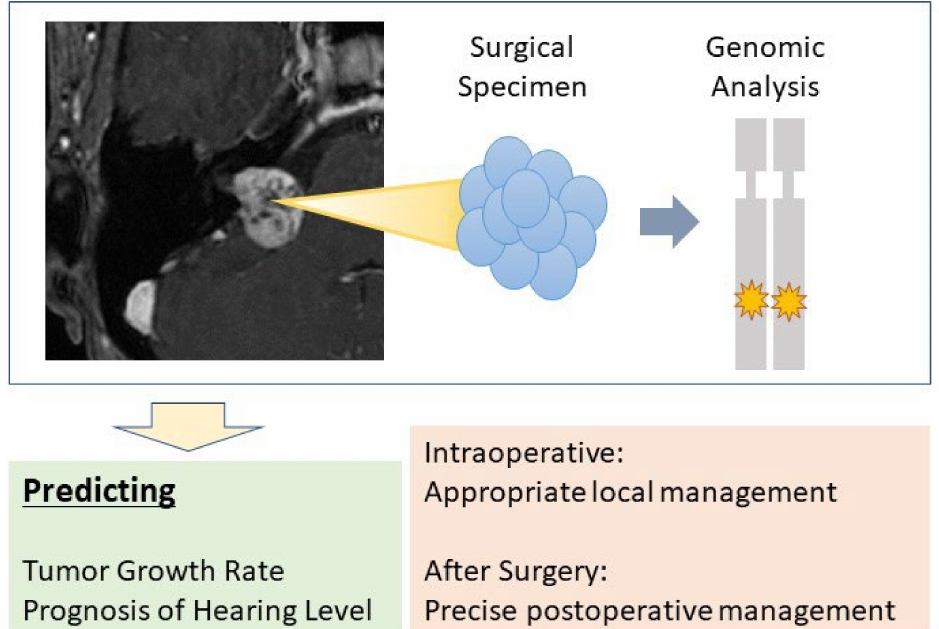
Figure 5. Clinical importance of genomic analysis for vestibular schwannoma. Predicting the clinical prognosis based on genomic analysis obtained from surgical specimens will help improve postoperative management. If intraoperative rapid analysis is possible, it will also help to improve the quality of the surgery by achieving the appropriate local